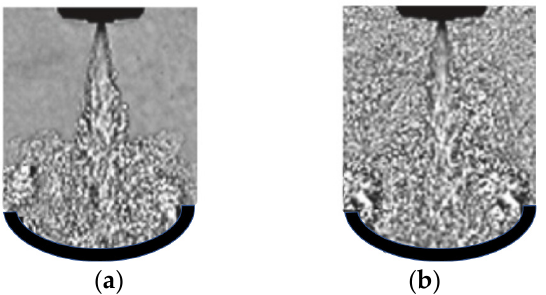
Figure 5. Shadowgraph photo capturing the combustion field in which fuel sprayed from the fuel injection nozzle collides with the curved surface at each time. ( a ) t = 3 ms. ( b ) t = 10 ms.